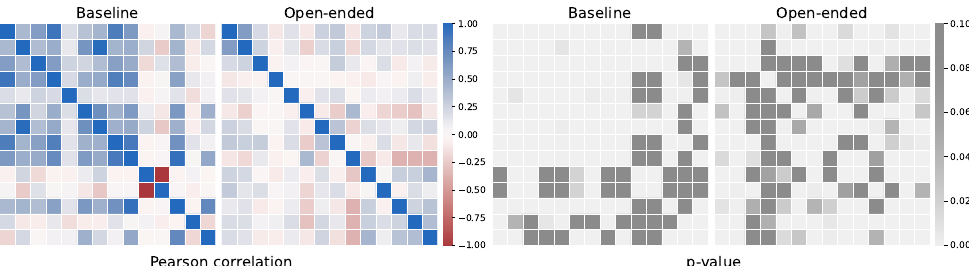
Figure 4. Correlation matrix between regressors. ( Left ) Pearson correlation with ( Right ) p -value.